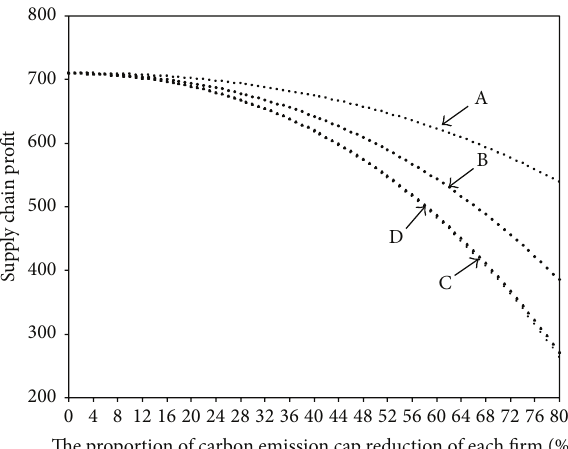
Figure 3: System profit when each company reduces carbon emissions by 1%–80%.